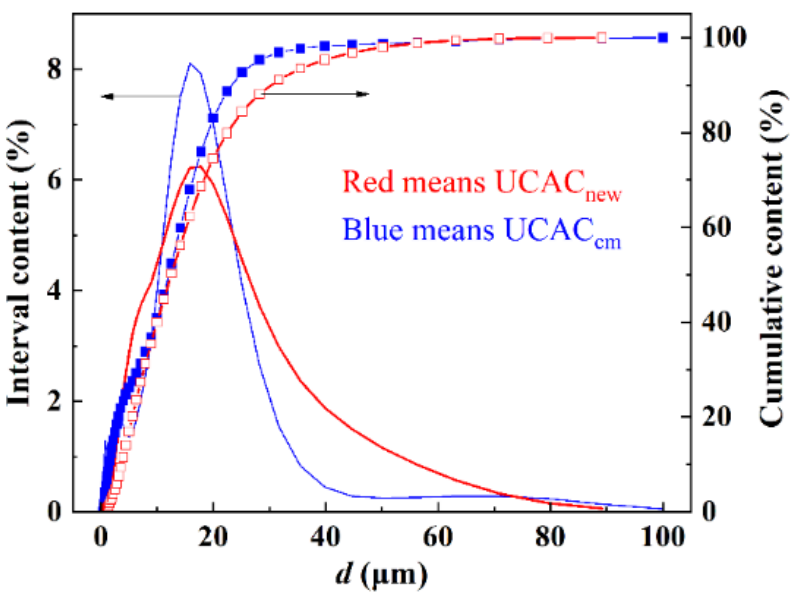
Figure 7. The PSD UCAC